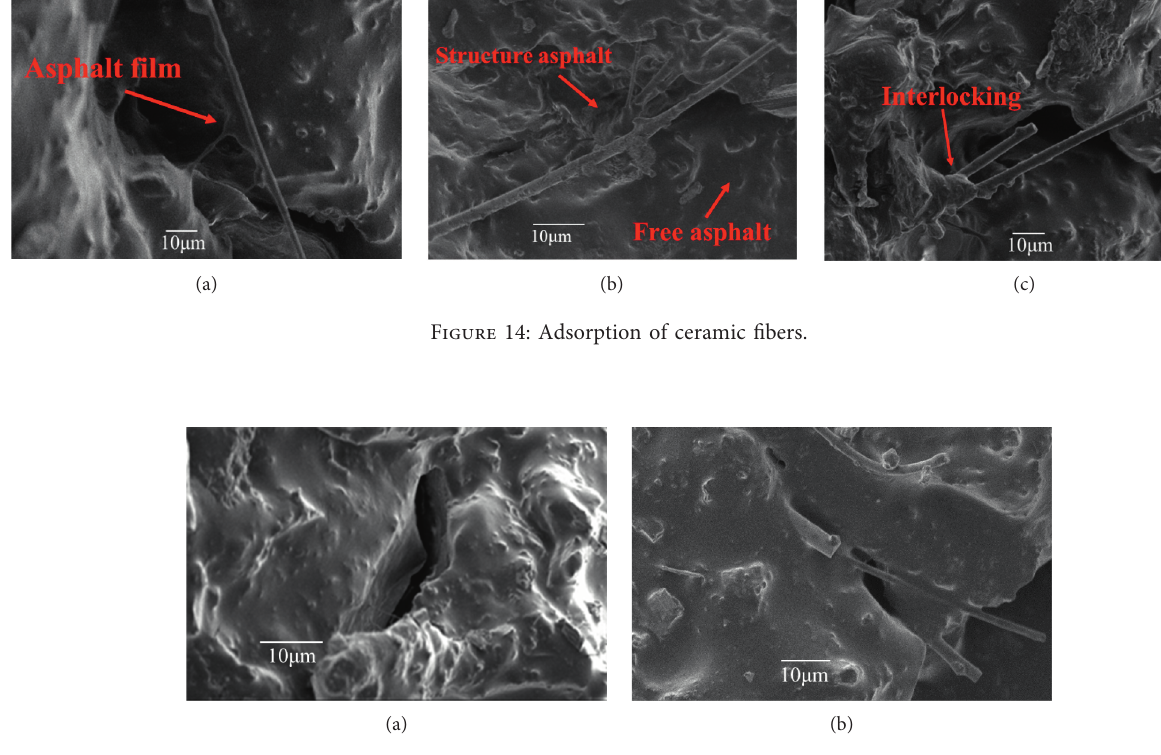
Figure 15: Cracks of asphalt mixture: (a) without ceramic fibers and (b) with ceramic fibers.